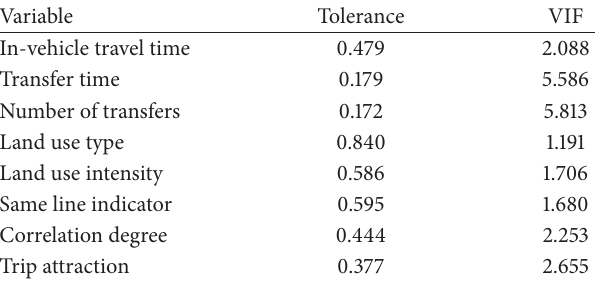
Table 3: Multicollinearity test